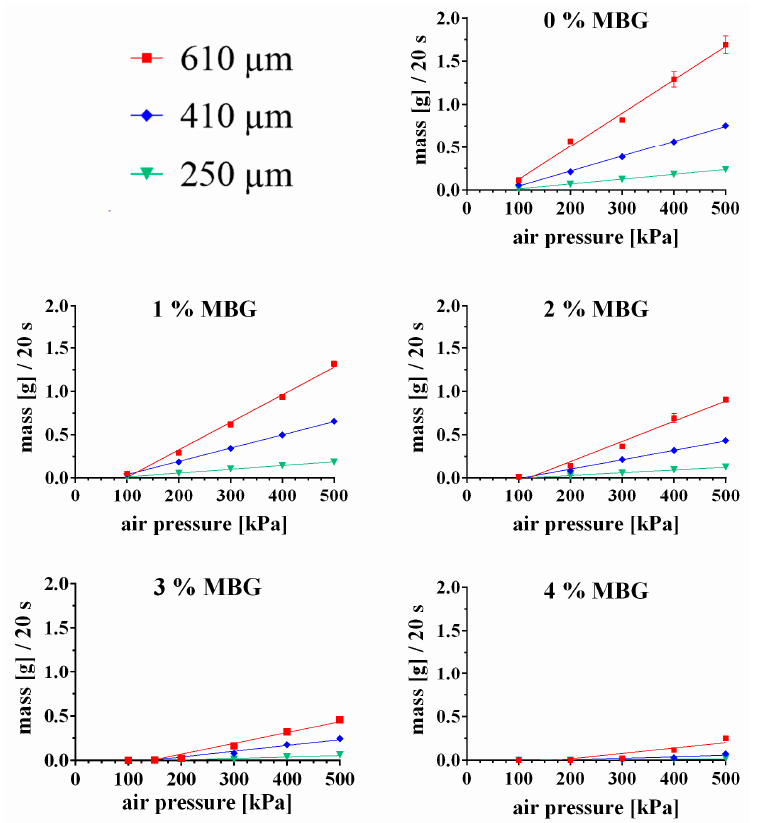
Figure 2. Extrudability, characterized by mass flow through di ff erent needle diameters (250 µ m—green, 410 µ m—blue, 610 µ m—red) of CPC pastes with di ff erent concentrations of incorporated MBG particles. Higher concentrations of MBG were not possible to extrude. (mean ± standard deviation, n = 3, please consider that most standard deviations are smaller than the data points). R 2 numbers of the curve fits are shown in Table 3. Table 3. Coefficients of determination of the linear fitted mass flow profiles dependent on different needle types (Figure 2).